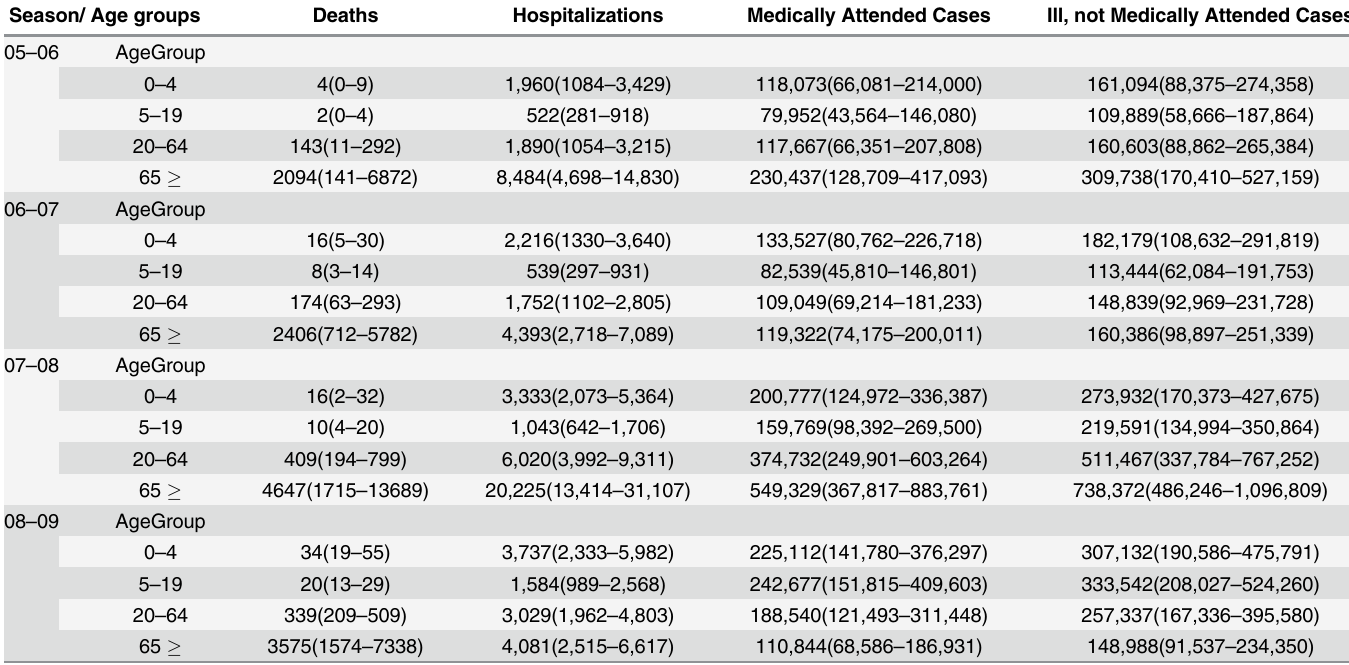
Table 1. Averted outcomes per season, and